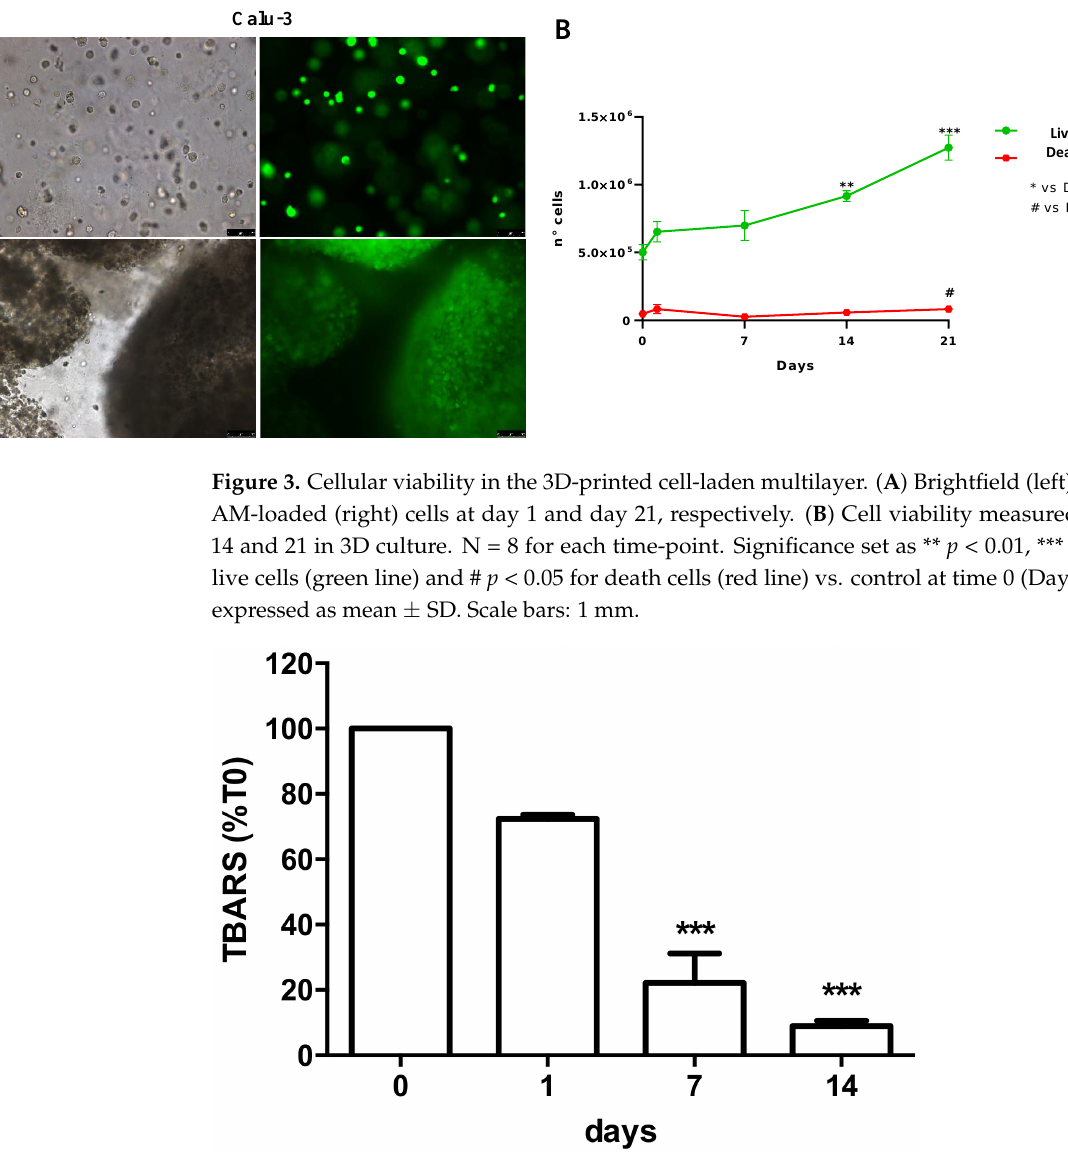
Figure 4. Thiobarbituric acid reactive substance assays (TBARS). TBARS for printed Calu-3 cells after hydrogel solubilization after 1 h (T0), and 1, 7 and 14 days in culture. *** p < 0.001 vs. T0. Data are expressed in %mean ± SD vs. T0, represented as percentage vs. control. N =